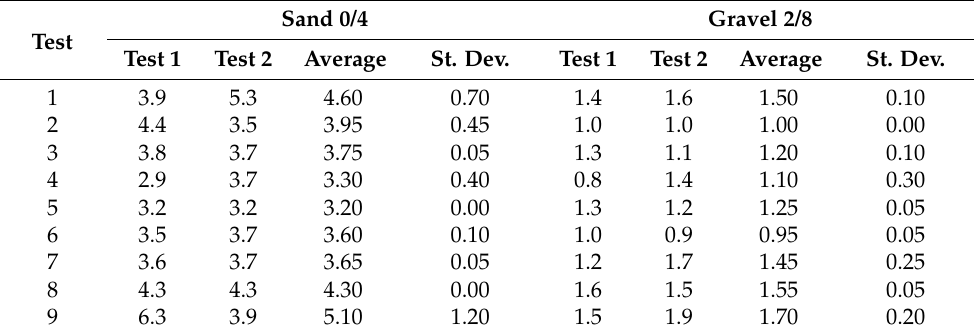
Table 14. Moisture content of materials used to produce high-strength self-compacting concrete at pilot plant